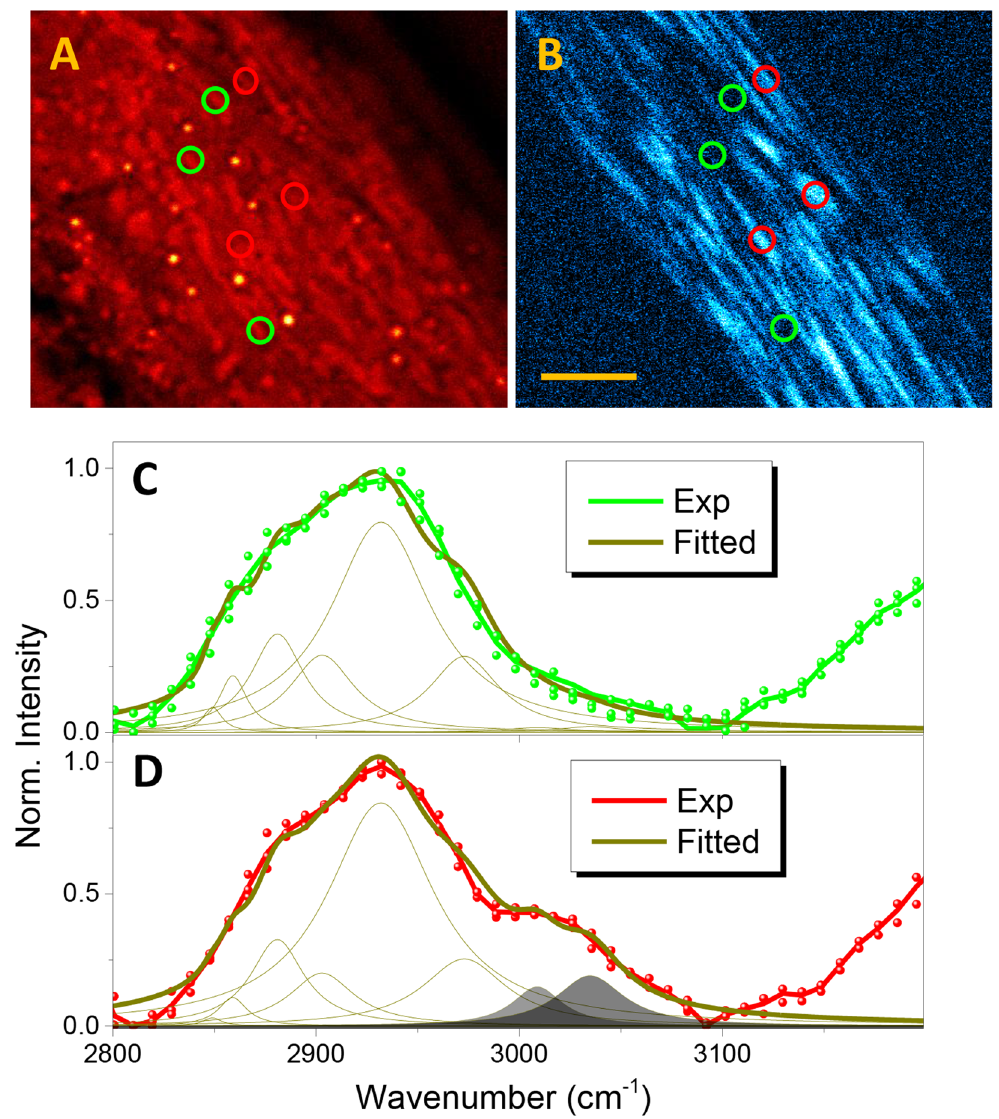
Figure 4. Morphological and chemical changes associated with mutagenesis in the muscle. The ( a ) spCARS and ( b ) SFG images of the body wall muscle of unc-89 mutant C. elegans, for the 2860 cm − 1 vibration mode. The scale bar represents 20 μ m. ( c ) and ( d ) show the spCARS spectra taken from the green (c) and red (d) circles in (a) and